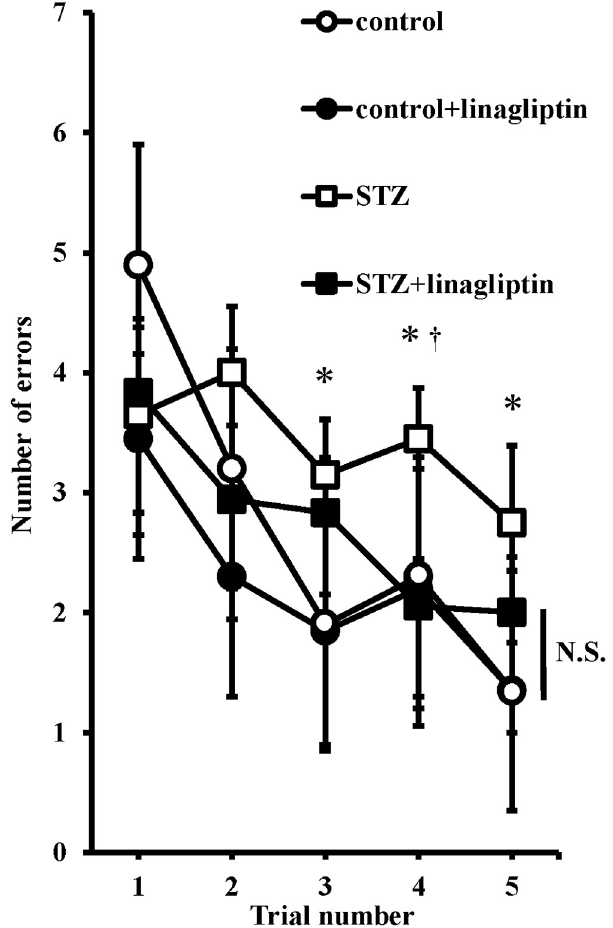
Fig 2. The effect of linagliptin on cognitive impairment. The mean number of errors in the radial arm water maze (RAWM). Four consecutive acquisition trials (trials 1–4) were followed after 30 min by a retention trial (trial 5). Bars represent means ± SEM (n = 8); � P < 0.05 vs. control, † P < 0.05 vs. linagliptin-treated diabetic mice (ANOVA). N.S., not